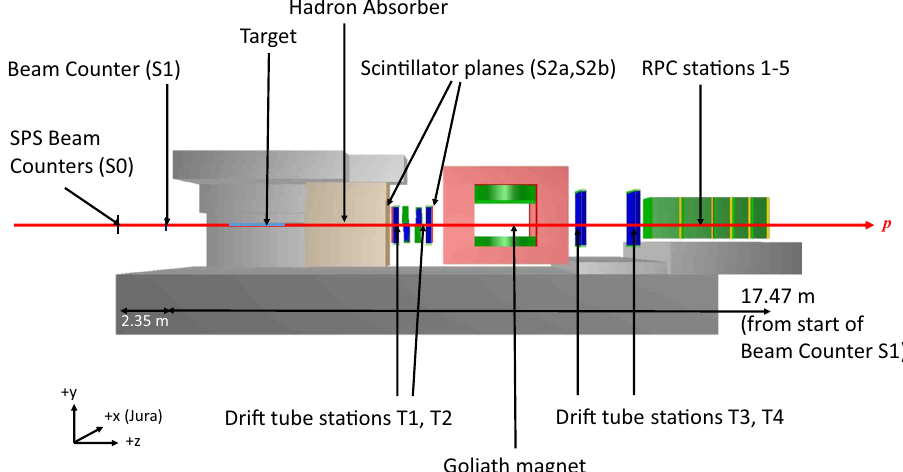
Fig. 1 Layout of